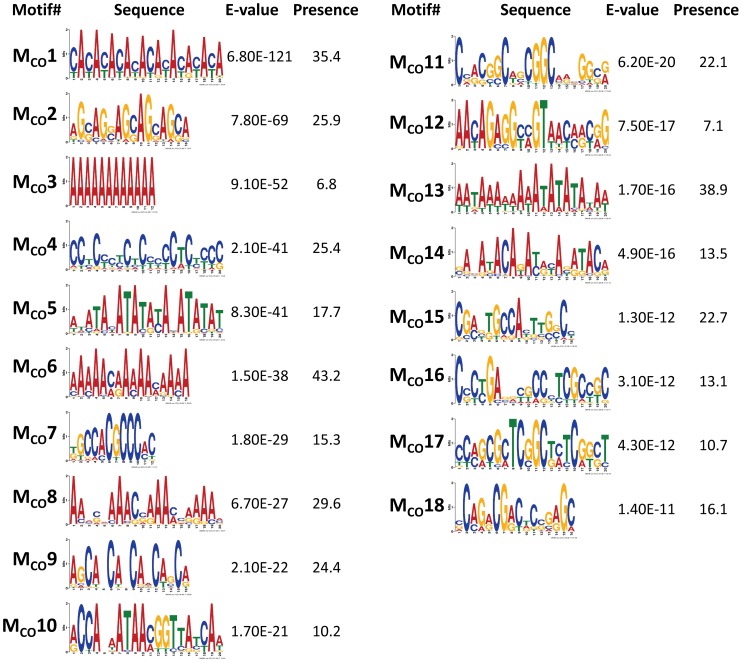
Top DNA motifs found enriched in sequences encompassing CO events.We focused on 1,909 CO events delimited by 500 bp or less (CO500 sequences). Only motifs with E-vale<1×10−10 are shown and ranked by E-value. Presence indicates the total number of motifs per 100 CO500 sequences, including the possible multiple presence in a single sequence. Motif MCO4 contains the 7-nucleotide motif CCTCCCT first associated with hotspot determination in humans [87] while motif MCO16 contains a 10-mer sequence (CCNTCGCCGC) that overlaps with the longer 13-mer CCNCCNTNNCCNC associated with crossover activity in human hot spots [86]. For display purposes, sequence motifs are chosen between forward and reverse to maximize the presence of A and/or C nucleotides.